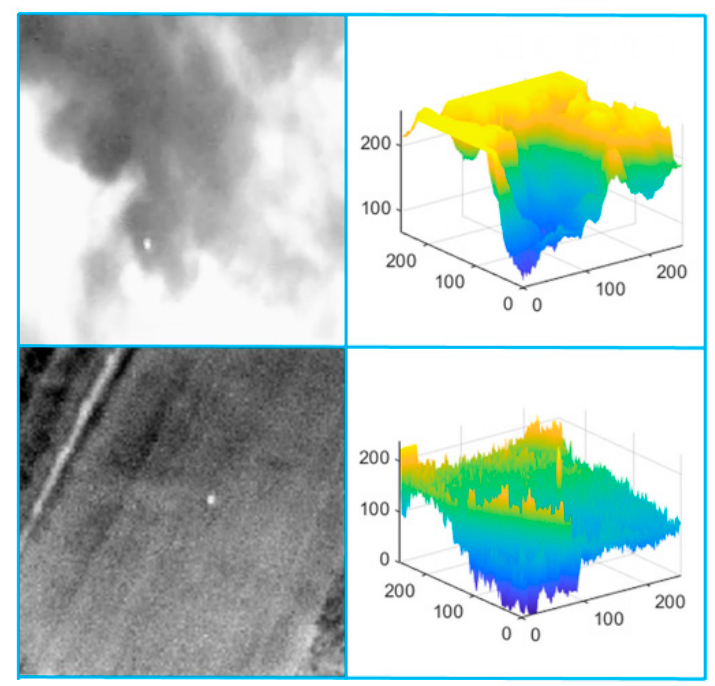
Figure 1. Background clutter and noise